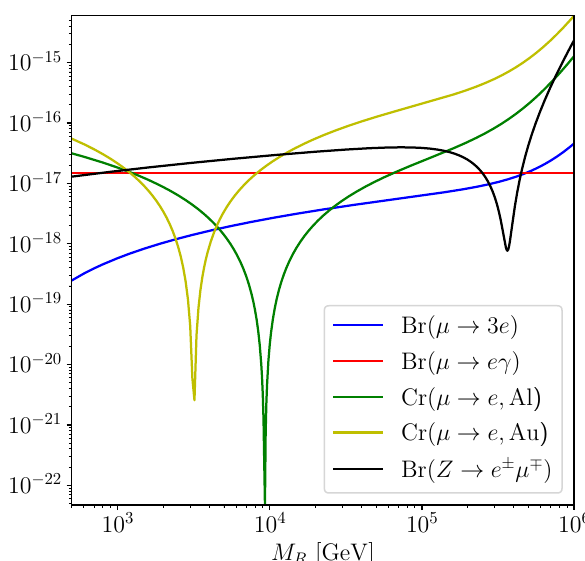
Figure 9. Branching ratios and conversion rates of processes involving µ → e transitions for degenerate sterile neutrinos of mass M , and with the Yukawa coupling structure given in eq. (2.15), R corresponding to the symmetry protected type-I seesaw. For this plot we set λ = M (10 6 GeV) , i R / i ∈ { e, µ, τ } , such that T ij is constant. Therefore, also Br( µ → eγ ) , which is proportional to T ij , is independent of M , whereas the amplitudes entering Br( µ → 3 e ) , Cr( µ → e ) and Br( Z → eµ ) involve R terms with four Yukawa couplings in addition. Furthermore, Cr( µ → e, Au) and Cr( µ → e, Al) feature target dependent blind